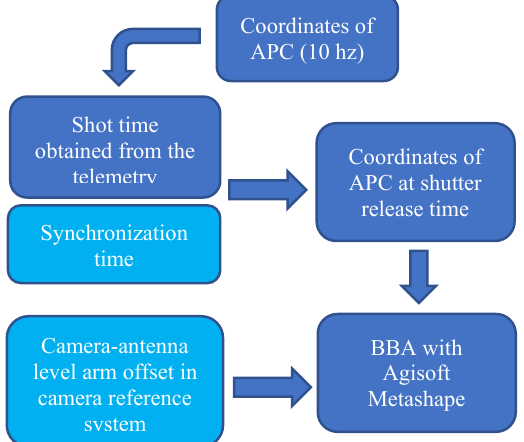
Figure 1. Flowchart of the Assisted Aerial Triangulation